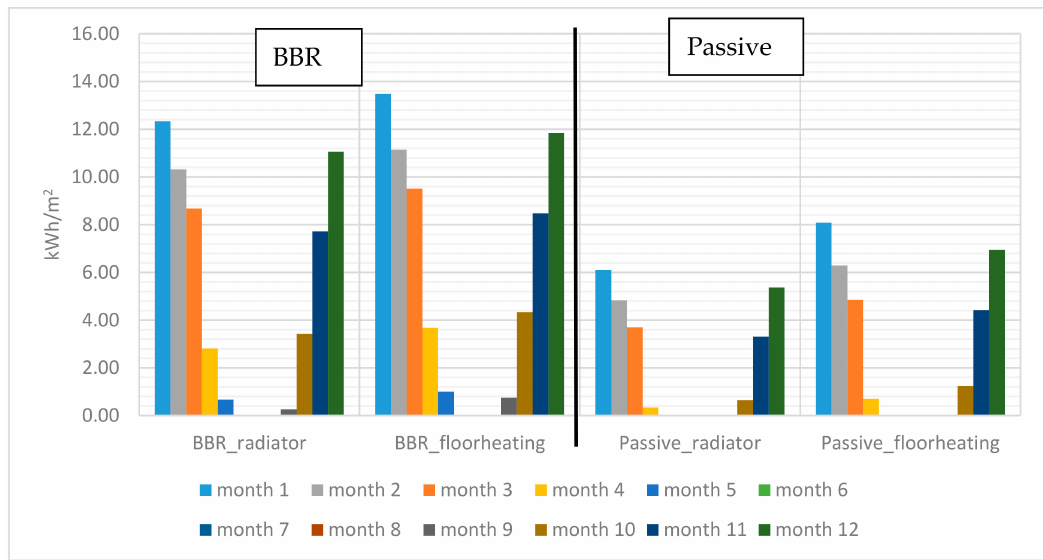
Figure 13. Monthly supply heating demand for space heating in all studied reference